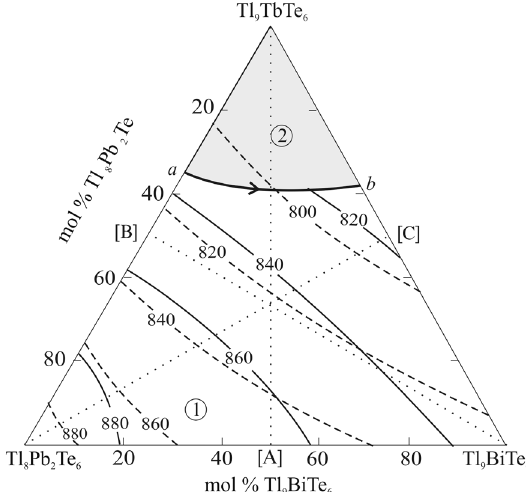
PbTe - 4 3 . 2 Te are presented 5 3 PbTe , Tl TbTe 4 3 9 6 Te with slight 5 3 TbTe . 9 6